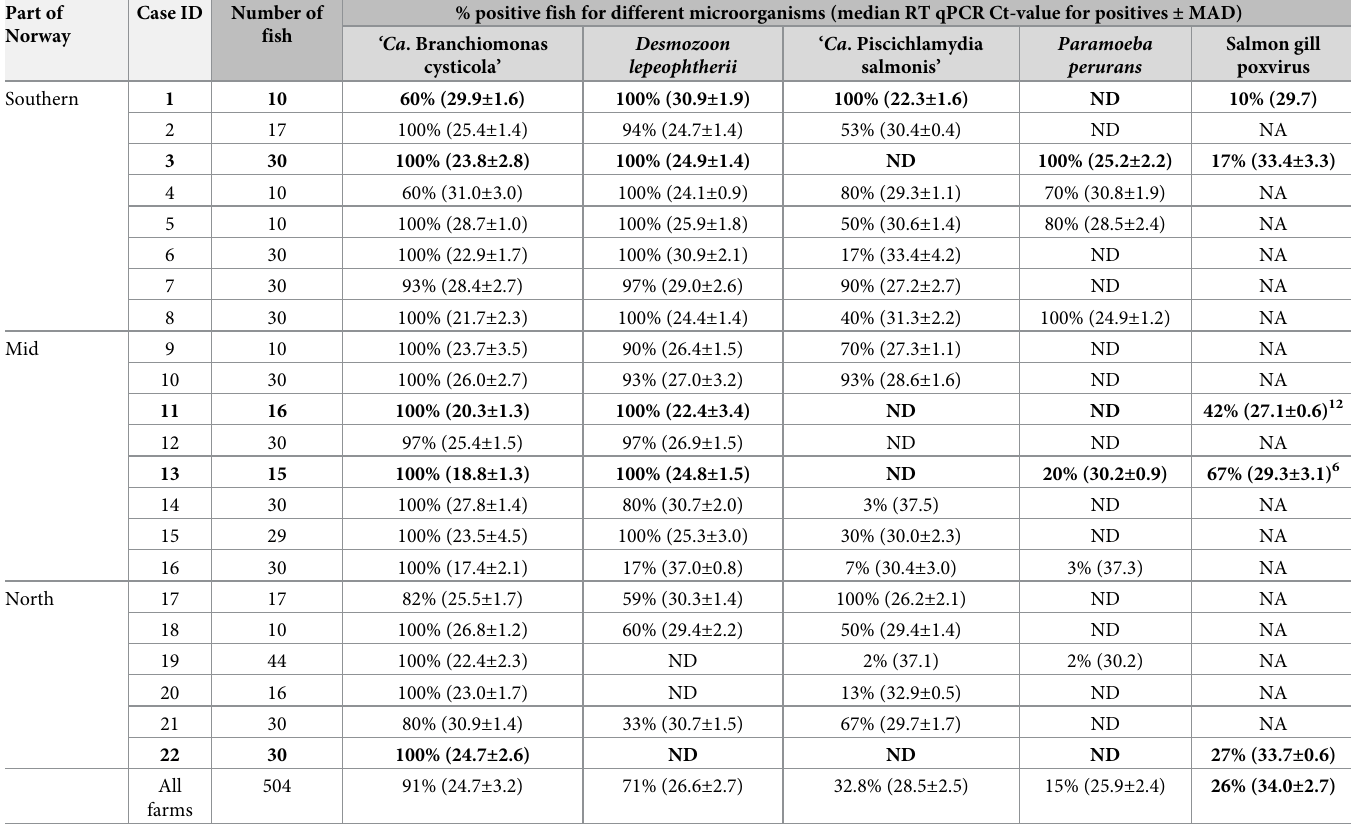
Table 1. Overview of geographical distribution of farms (Case ID), number of fish included from each case and agent load. Abbreviations: ND = not detected, NA = not analyzed. Samples from cases in bold were included in the histopathological investigation; 12 = twelve and 6 = six fish were tested for salmon gill poxvirus. Part of